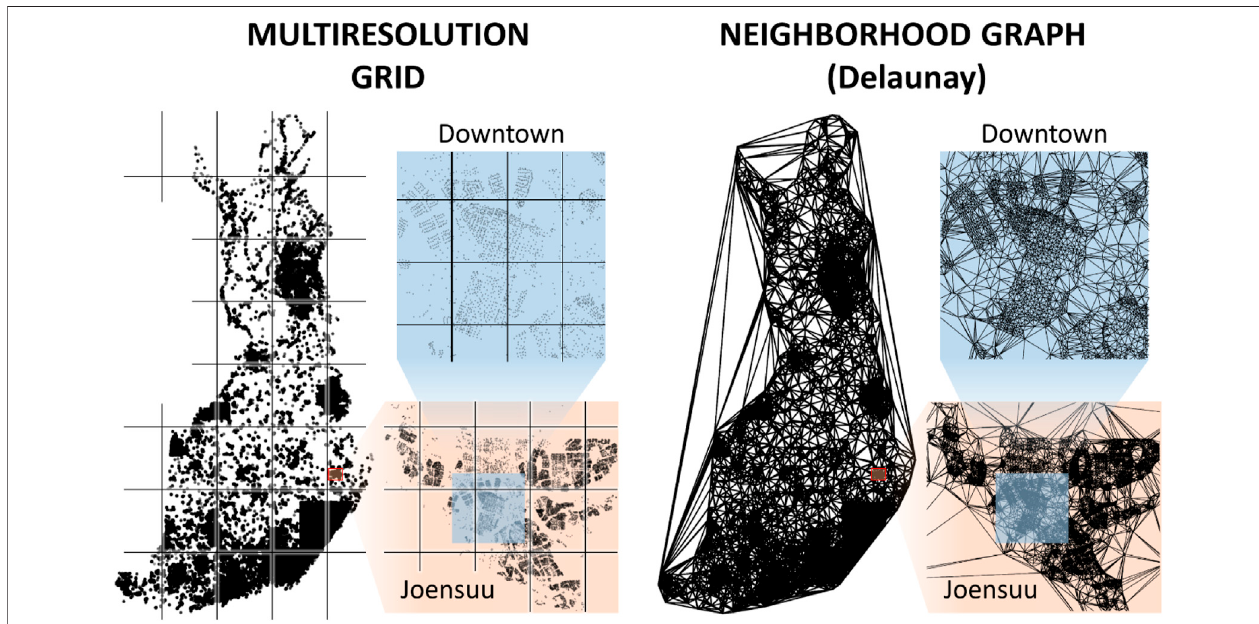
FIGURE 4 | Ef fi ciency of the local search operators depends highly on how to limit the search for candidates within the neighborhood. The grid-based approach restricts the two operands (links) to be in the same or neighboring grid cells, while a neighborhood graph considers only connected nodes.